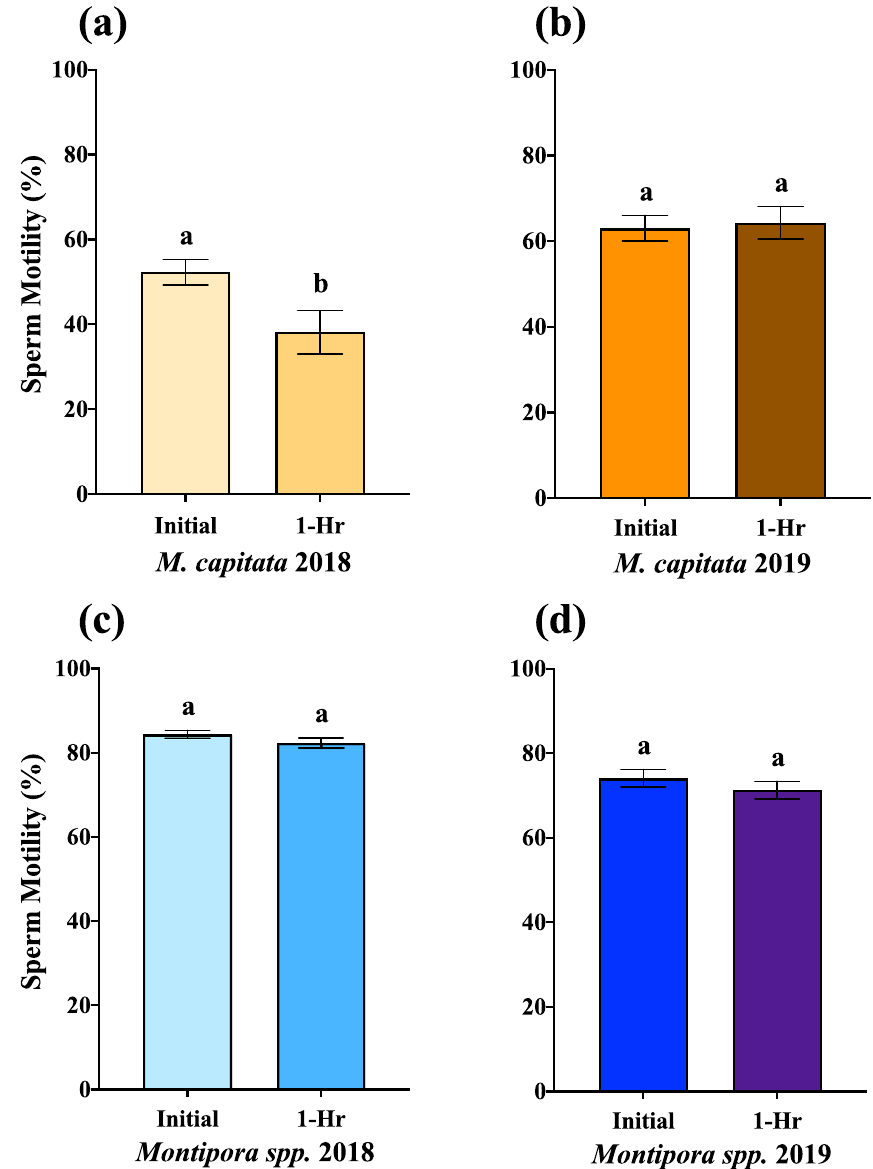
Figure 5. Initial percent sperm motility and 1-Hour reassessment. The difference in initial mean percent sperm motility shortly after bundles had broken apart and one hour after initial assessment for both species each year. ( a ) M. capitata 2018 (n = 31 Initial, n = 31 1-Hr, p = 0.0041, Welch’s t = 3.03). ( b ) M. capitata 2019 (n = 23 Initial, n = 23 1-Hr, p = 0.7089, Welch’s t = 0.3759). ( c ) Montipora spp . 2018 (n = 136 Initial, n = 136 1-Hr, p = 0.2296, Welch’s t = 1.204). ( d ) Montipora spp . 2019 (n = 61 Initial, n = 61 1-Hr, p = 0.2855, Welch’s t = 1.073). Percent sperm motility maintained similar levels after an hour of swimming in Montipora spp . both years and M. capitata in 2019, whereas motility in M. capitata 2018 declined over an hour. Error bars are SEM, and different letters above error bars indicate significant difference. (GraphPad Prism 9 v. 9.0.1; San Diego, CA, USA, www. graph pad.